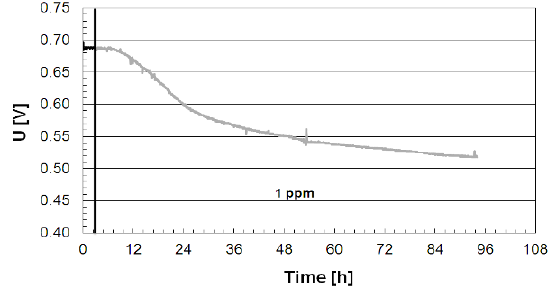
S on the SOFC cell performance 2 at 250 mA cm -2 current density at 750°C for the fuel /%50N ) humidified with 3% H O. (50%H 2 2 2